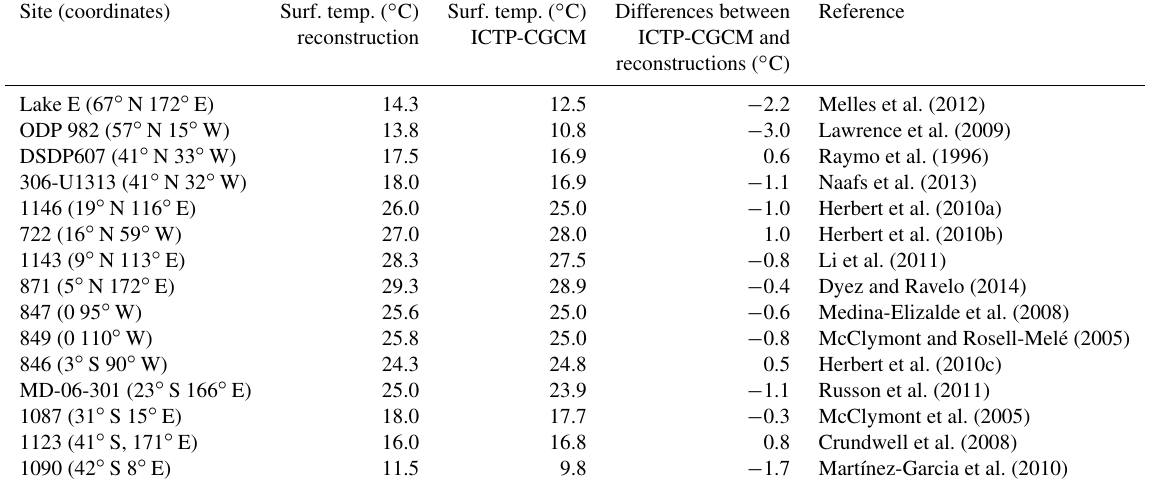
Table 2. SST paleoreconstruction and modeling intercomparison. Values in Table 2 have been extracted by drawing an orthogonal line to the time series with an intersection at approximately 1070ka between the dashed lines of Fig. 5 in Wet et al. (2016). Site (coordinates) Surf. temp. ( ◦ C) Surf. temp. ( ◦ C) Differences between Reference